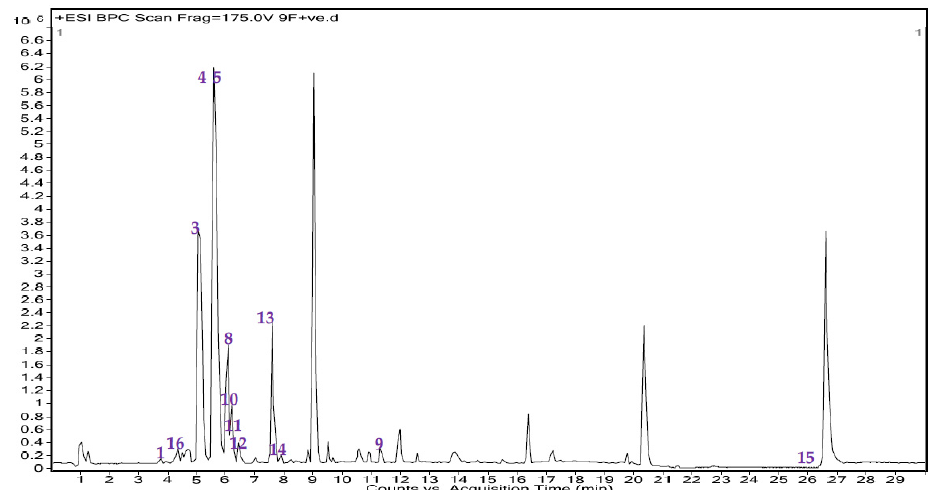
Figure 2. Positive ion chromatogram of TCAF2.